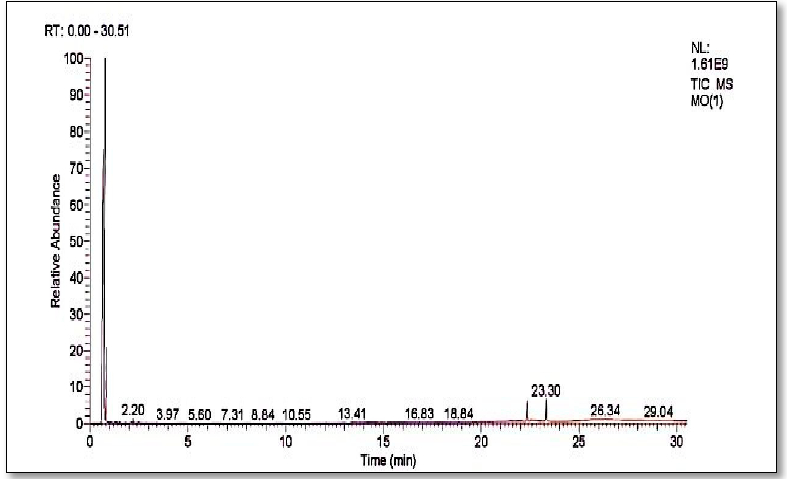
Figure 10. GC chromatogram of methyl orange dye after Pseudomonas aeruginosa degradation. Table 1. GC-MS analysis and Identified compounds from degraded mixture.